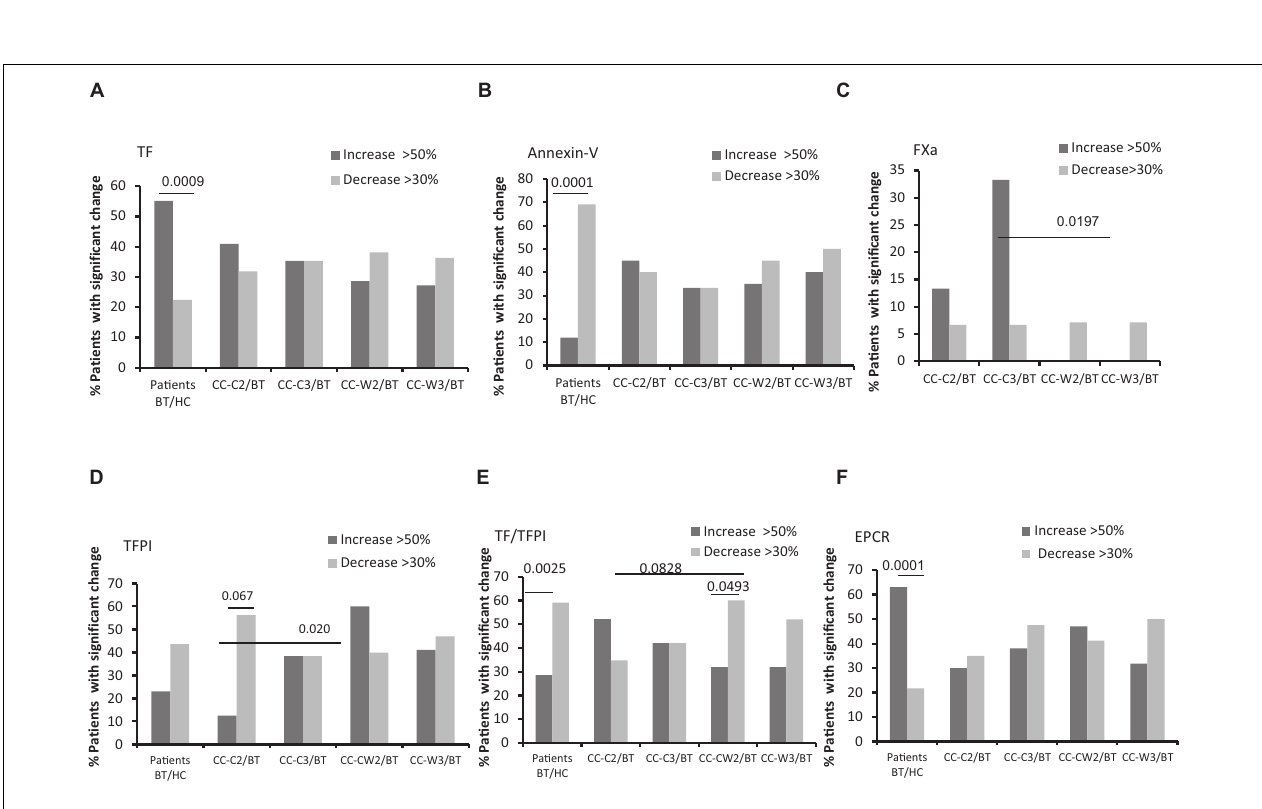
FIGURE 5 | EVs thrombogenicity. Antigen levels of coagulation markers were measured on EVs obtained from healthy controls and from patients before chemotherapy (BT, time point 1), during treatment (time point 2), and at the end of chemotherapy treatment (time point 3), using specific fluorescent antibodies. The percentage of labeled EVs was calculated from the total number of EVs using FACS analysis. The graph presents significant changes ( > 50% increase or > 30% decrease) in patient EVs levels BT compared to HC and the change during treatment and at the end of chemotherapy treatment compared to the levels BT related to% TF labeled EVs (A) ; % TFPI labeled EVs (B) ; TF/TFPI EVs ratio (C) ; % EPCR labeled EVs (D) ; % Annexin V (E) ; % EVs procoagulant activity was measured by factor X chromogenic assay (F) .